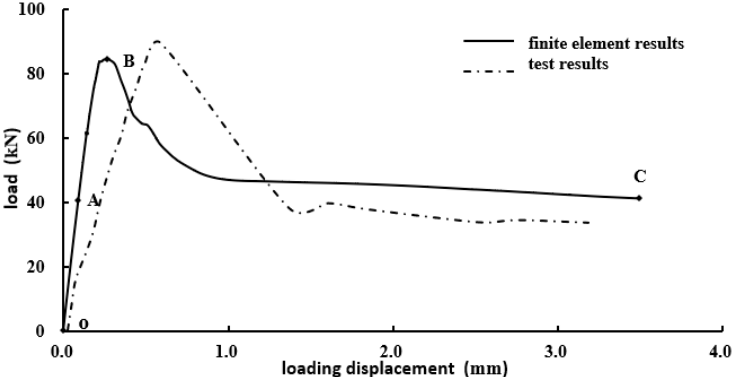
Figure 6. Load-displacement curve of F1.0- d 35-A25/35-B100 specimen.